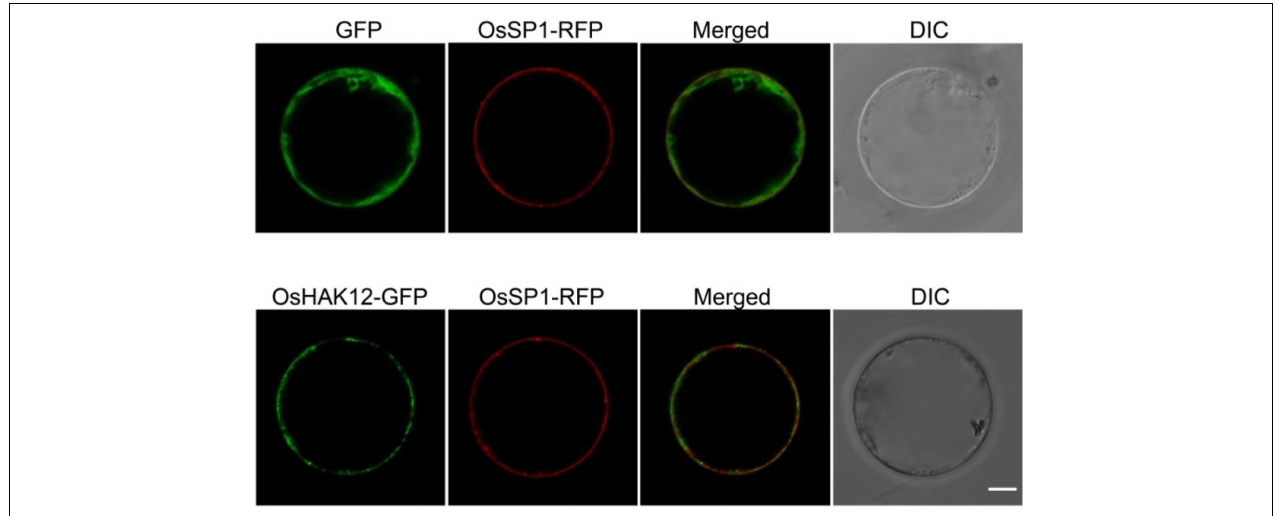
FIGURE 3 | Plasma membrane localization of OsHAK12. GFP, OsHAK12-GFP, and OsSP1-RFP (a plasma membrane localization marker) in rice mesophyll protoplasts. For each localization experiment, ≥ 35 individual cells were analyzed using a Zeiss LSM880 confocal laserscanning microscope (Carl Zeiss). Bar = 10 µ m.